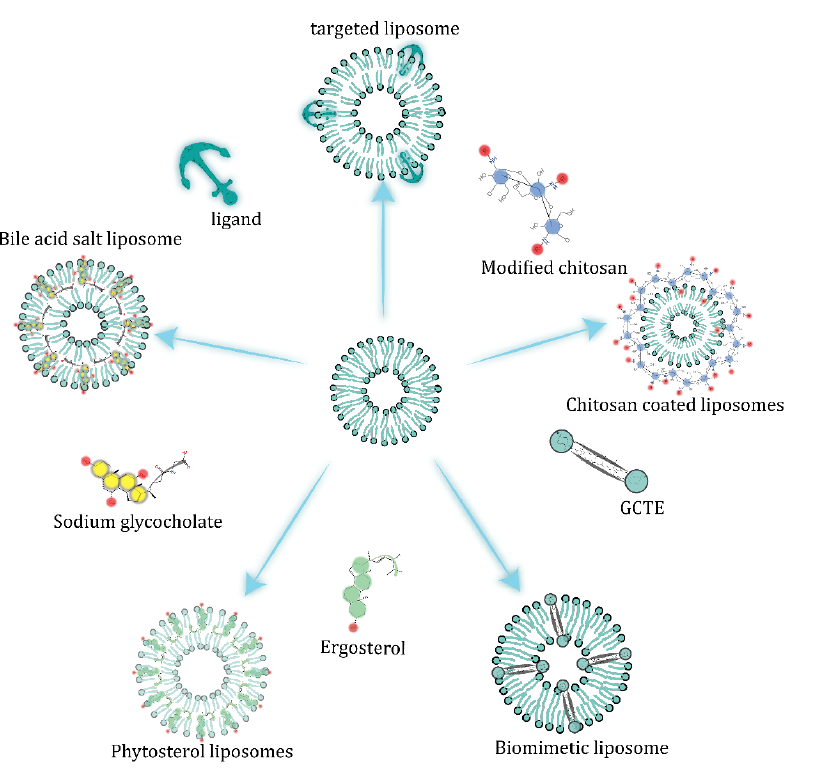
Figure 3. Liposome modification